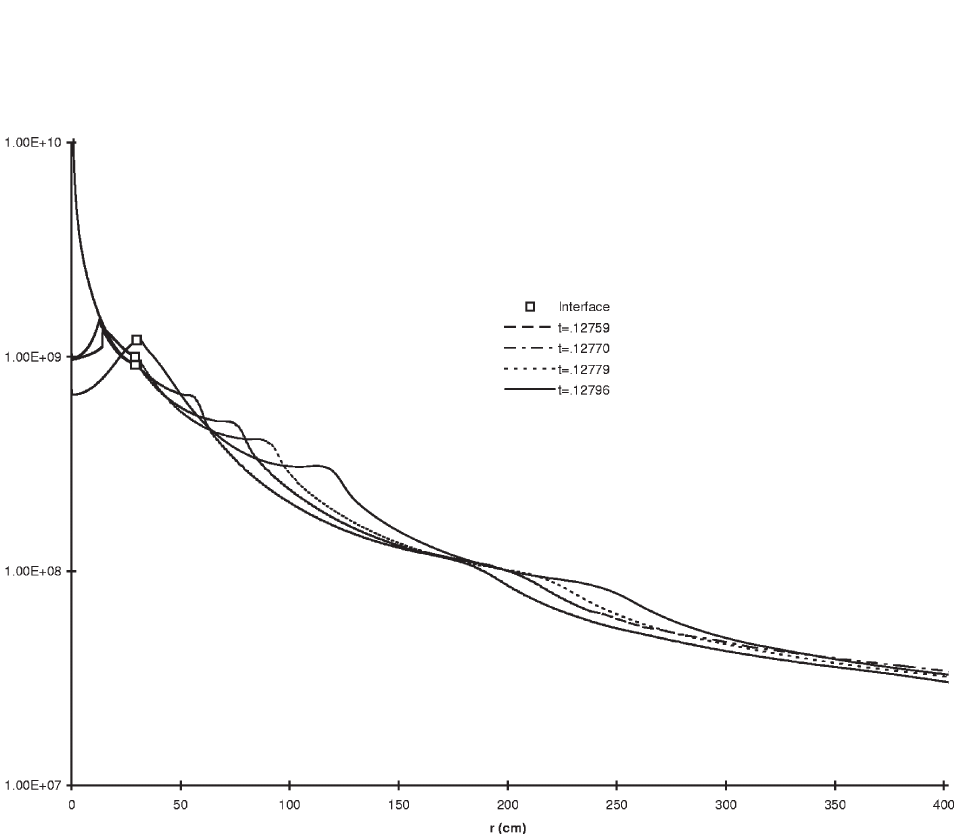
Fig. 6. Non-Uniform Euler Model bubble